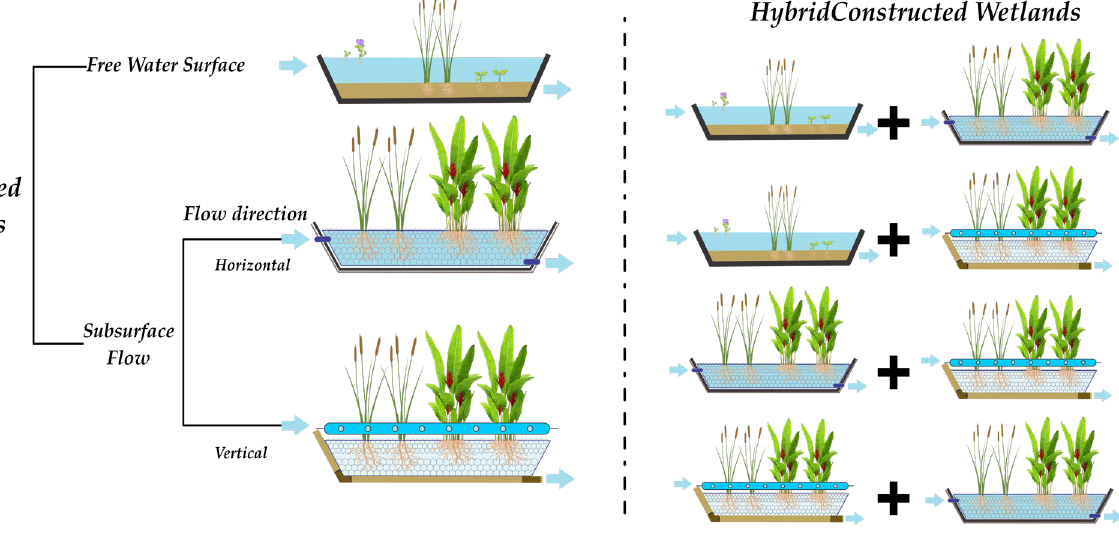
Figure 1. Scheme of constructed wetland types.